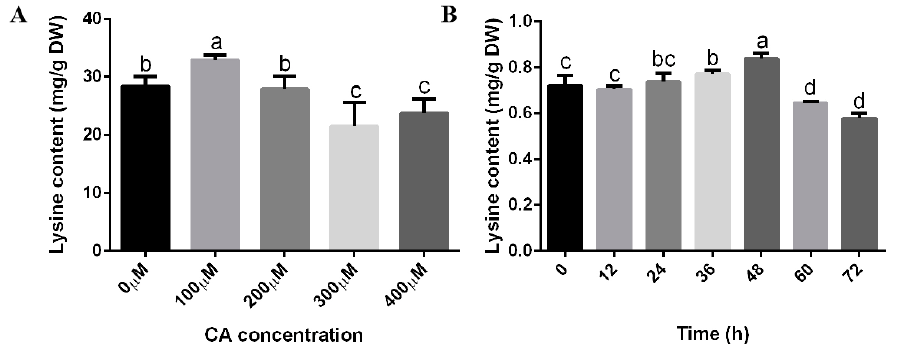
Figure 2. Effects of citric acid and treatment time on lysine and protein in Flammulina filiformis mycelium. ( A ) The content of lysine induced by different concentrations of citric acid was detected in WT strain of F. filiformis . Different letters indicate a significant difference between treatment groups ( p < 0.05). ( B ) The content of lysine induced by 100 μ M citric acid was detected in WT strain of F. filiformis . Different letters indicate a significant difference between treatment groups ( p < 0.05).